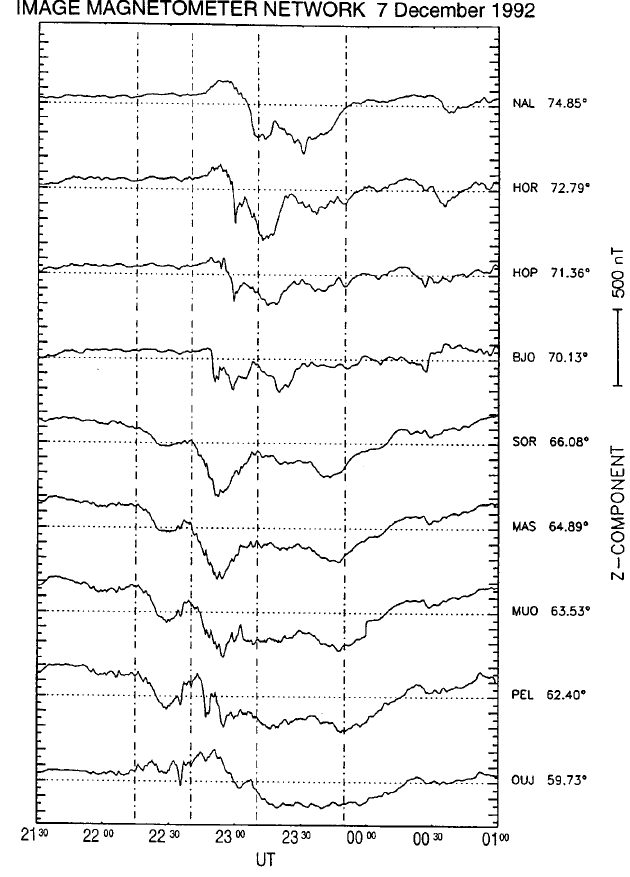
Fig. 4a, b. IMAGE magnetometer chain data for 7 December–8 December 1992. Four hours of data are shown as indicated by the UT at the bottom of each panel . a Shows the X -component of the magnetic field and b the Z -component. The station names and their magnetic latitudes are shown between the plots. The vertical dash-dot lines